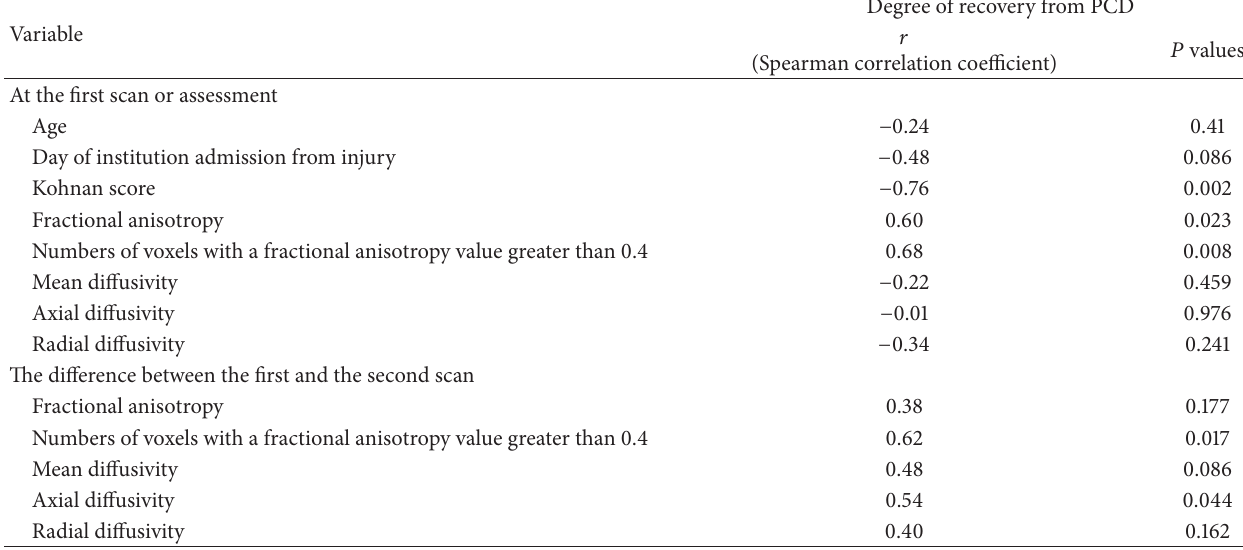
Table 6: Correlation between the degree of recovery from prolonged consciousness disorder and each value.